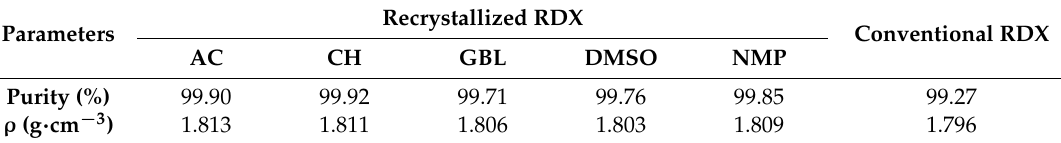
Figure 4. The photos of conventional RDX and RDX crystal from five solvents including acetone ( a ); cyclohexanone ( b ); γ -butyrolactone ( c ); dimethyl sulfoxide ( d ); and N -methyl-2-pyrrolidone ( e ) ; conventional RDX ( f ) respectively. Table 5. The purity and apparent density of RDX.